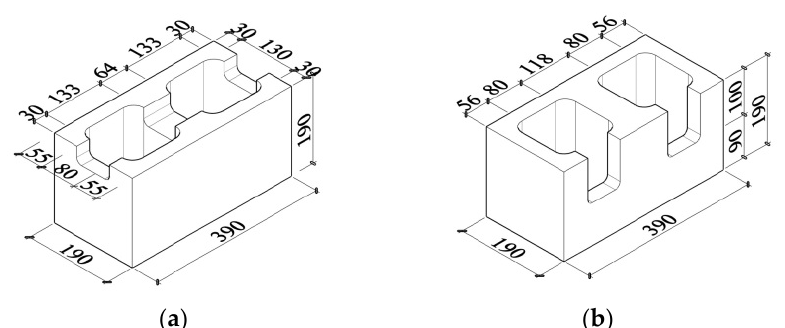
Figure 3. Dimensions of the ( a ) bond-beam units and ( b ) cleaning-hole units